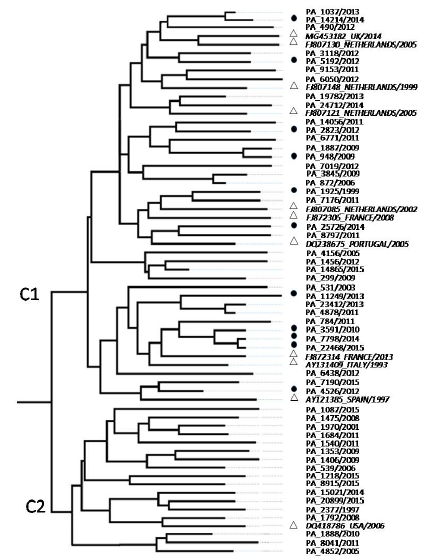
Figure 2. NS5B region (425 bp) maximum clade credibility tree (Tamura-Nei ’93 model, visualized with FigTree software). White triangles represent HCV-4d sequences from GenBank (accession number_country / year) and the black circles represent Sicilian sequences (PA_number / year) obtained from HIV co-infected